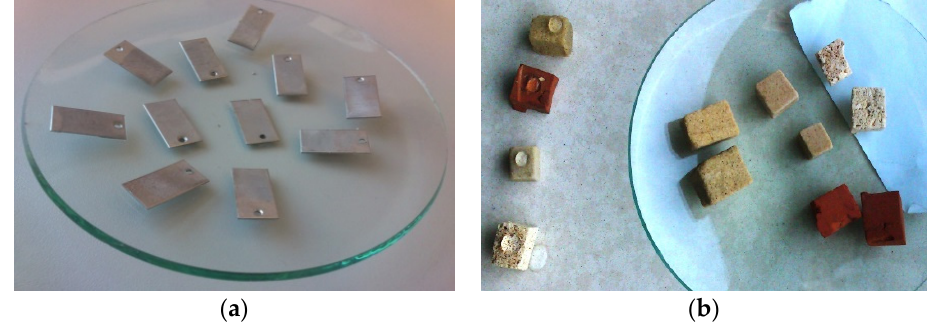
Figure 1. Two different types of substrates: ( a ) metallic samples; ( b ) porous